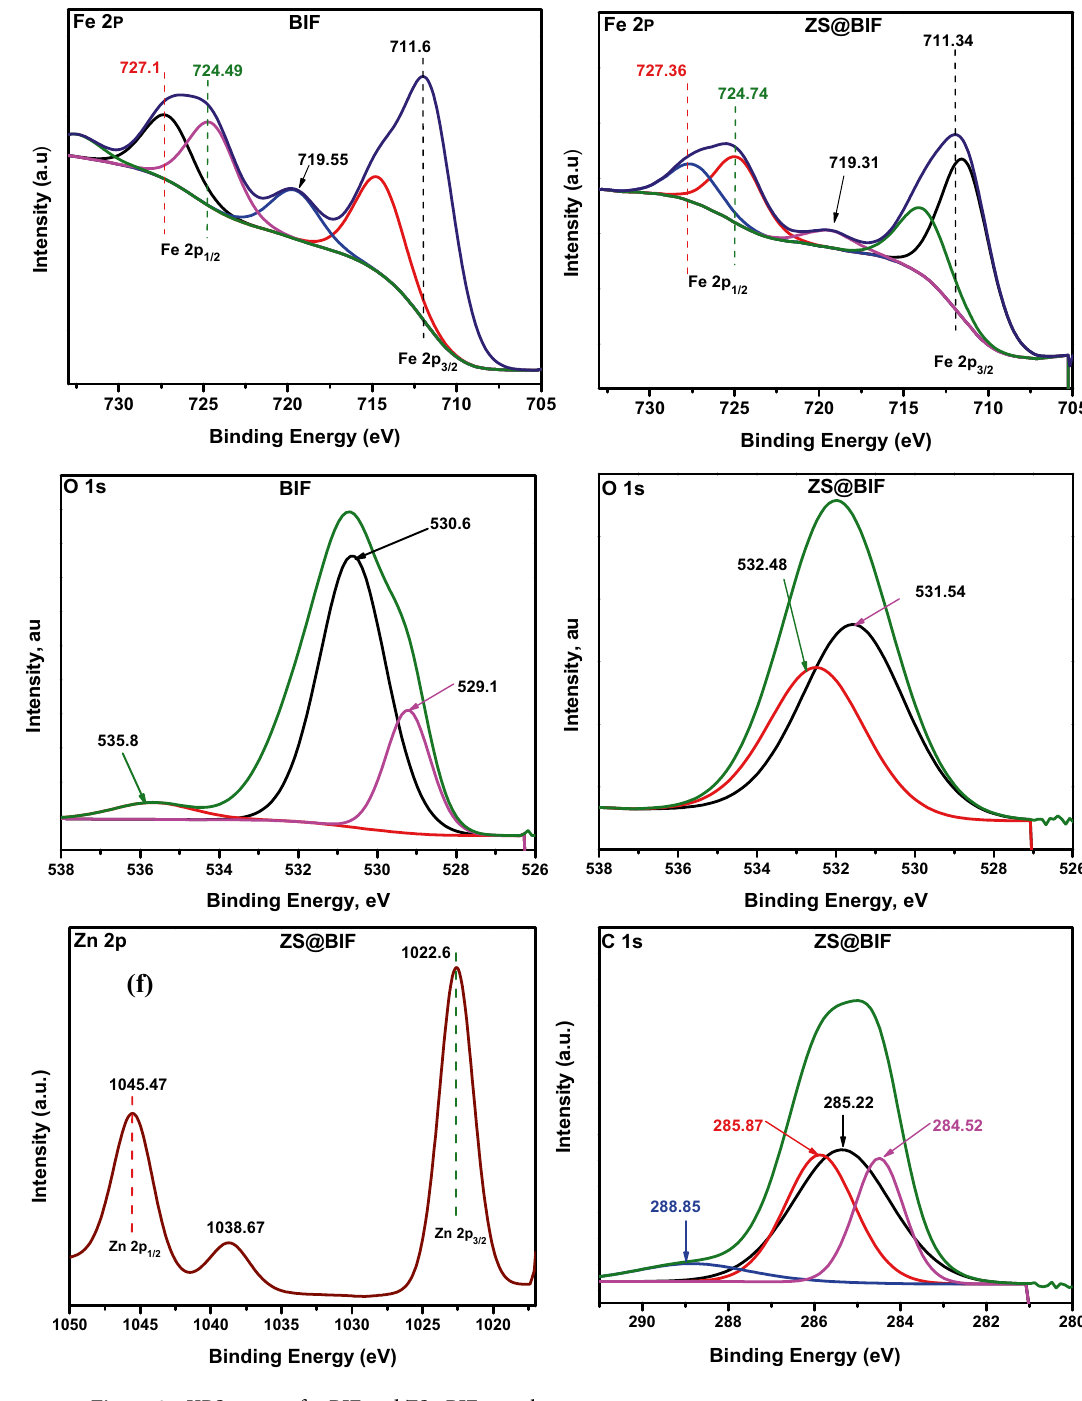
Figure 3. XPS spectra for BIF and ZS@BIF